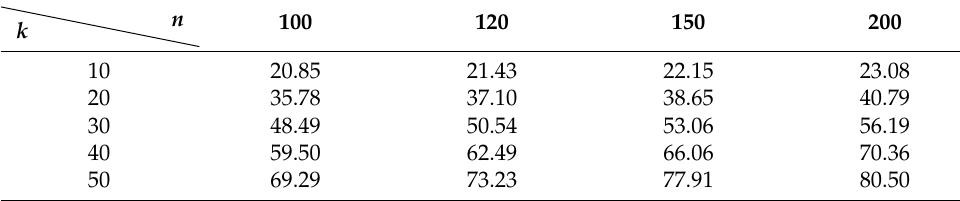
Table 1. The critical values of T k in the case of m = 5 and significance level α =